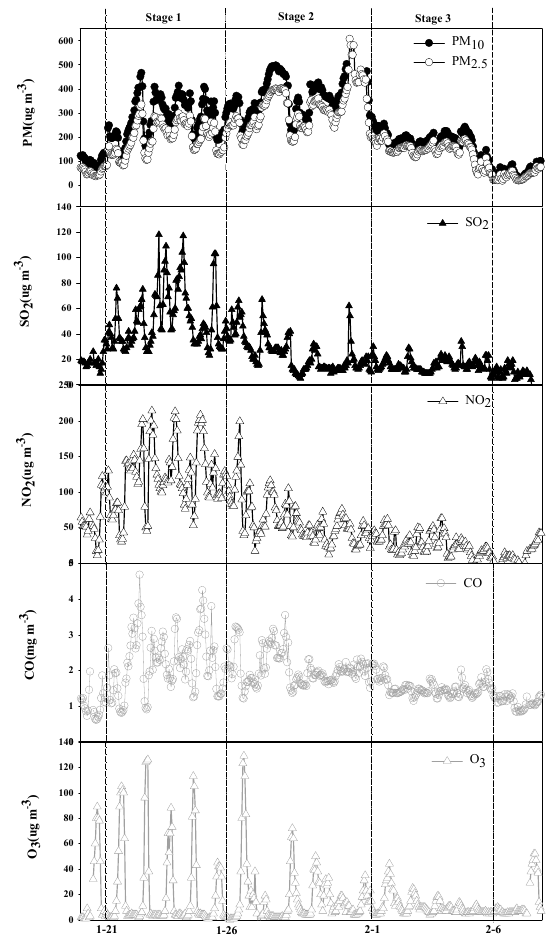
Figure 1. Variation of particle matter (PM 10 and PM 2.5 ) and gaseous pollutants (SO 2 , NO 2 , CO, and O 3 ) in Chengdu during the period of the 2014 spring festival. Atmosphere 2017 , 8 , 71 7 of 17